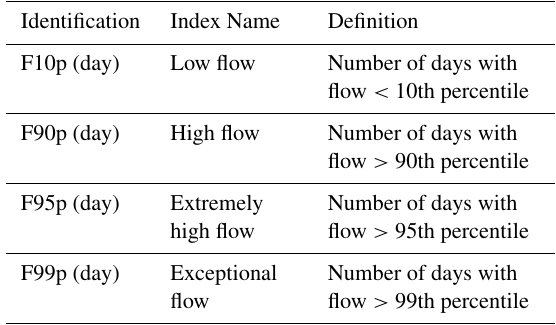
Table 1. Extremes flow